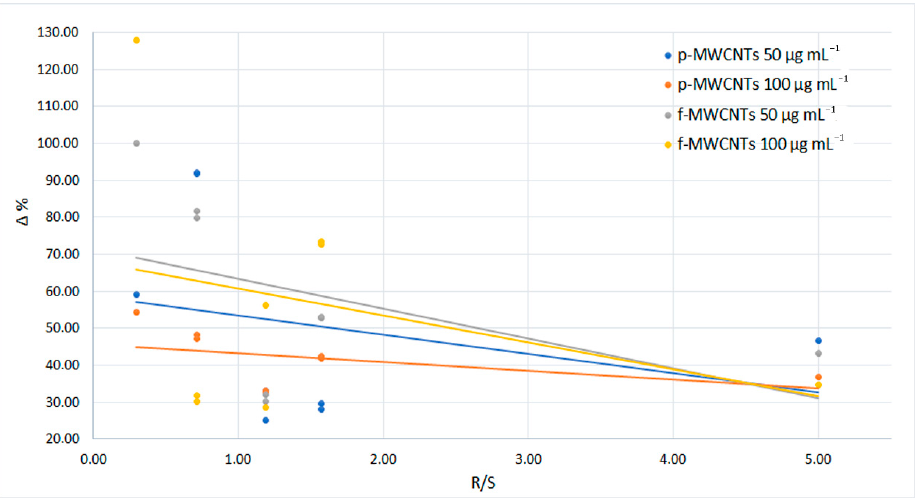
Figure 2. Correlation between the percentage increase of MWCNT antimicrobial activity and the R/S ratio of the studied bacterial strains.